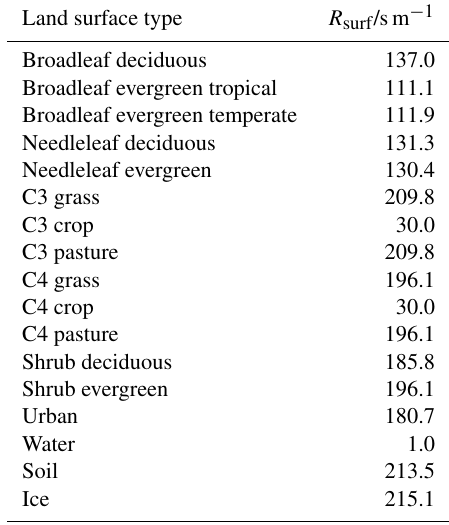
Table A2. Standard surface resistance ( R surf ) values for SO 2 for land use types in UKESM1. These values were calculated based on the data published in Zhang et al. (2003) for SO 2